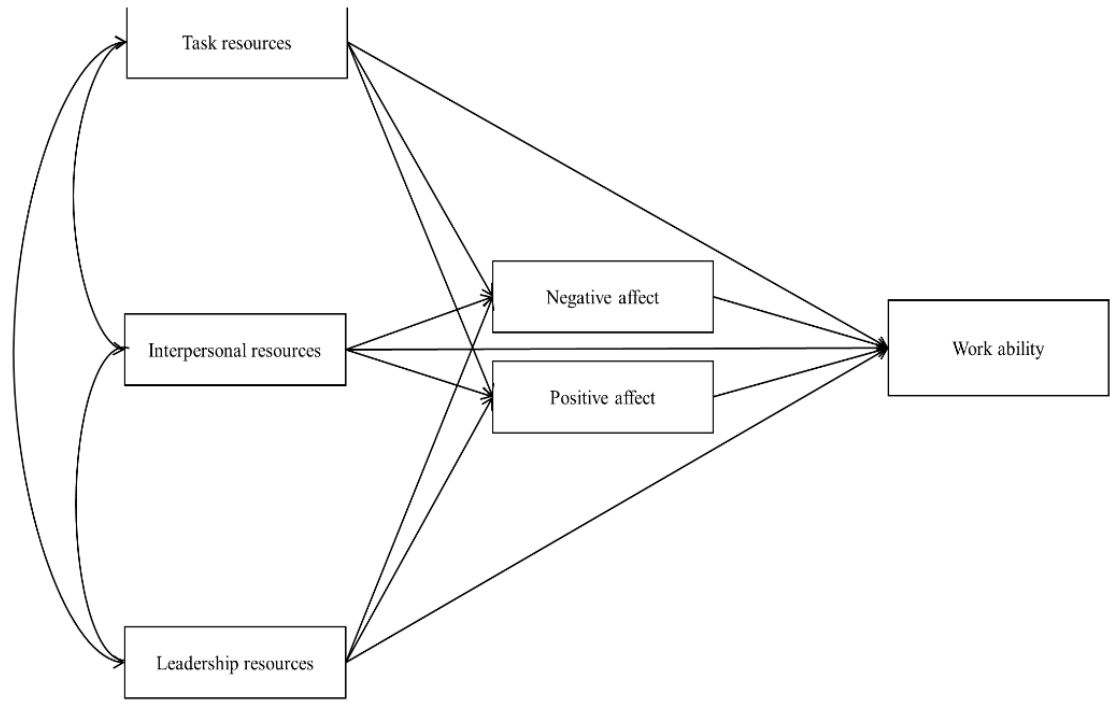
Figure 1. Theoretical model.